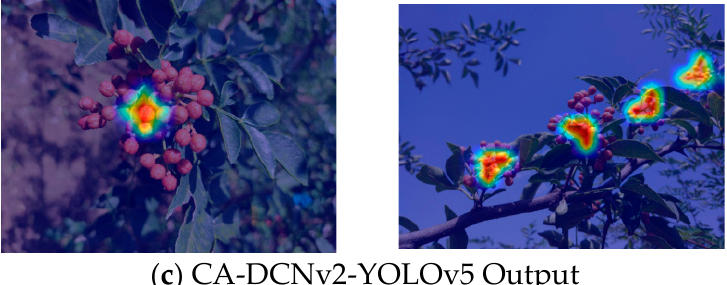
Figure 13. Class activation mapping.